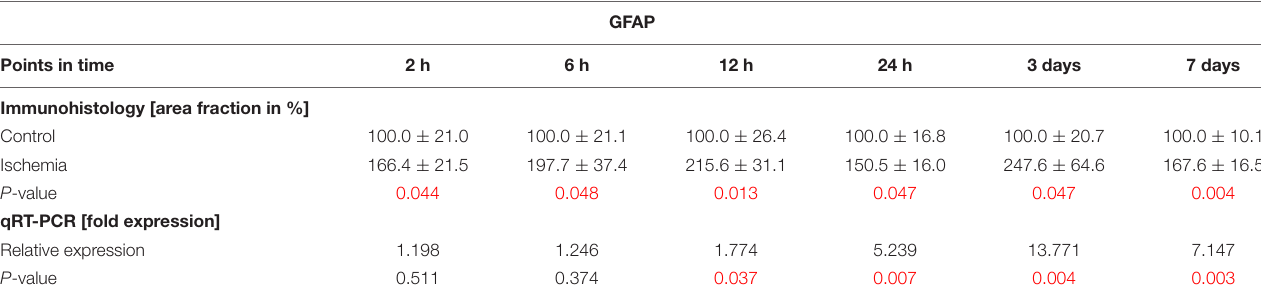
FIGURE 6 | (A) Macroglia were detected with anti-GFAP (red), while DAPI was used for cell nuclei (blue; n = 7–8/group). Control retinae displayed GFAP in the GCL and NFL, while the signal spread to inner layers after ischemia. (B) An increase of GFAP + area was measured after I/R for all points in time (2 h: p = 0.044; 6 h: p = 0.048; 12 h: p = 0.013; 24 h: 0.047; 3 days: 0.047; 7 days: 0.004). (C) Compared to controls, Gfap mRNA level was significantly higher at 12 h ( p = 0.037), 24 h (0.007), 3 days ( p = 0.004), and 7 days ( p = 0.003) after ischemia. ∗ p < 0.05, ∗∗ p < 0.01. GCL, ganglion cell layer; IPL, inner plexiform layer; INL, inner nuclear layer. Scale bar: 20 µ m. TABLE 7 | Analyses of the GFAP area (%), where control groups were set at